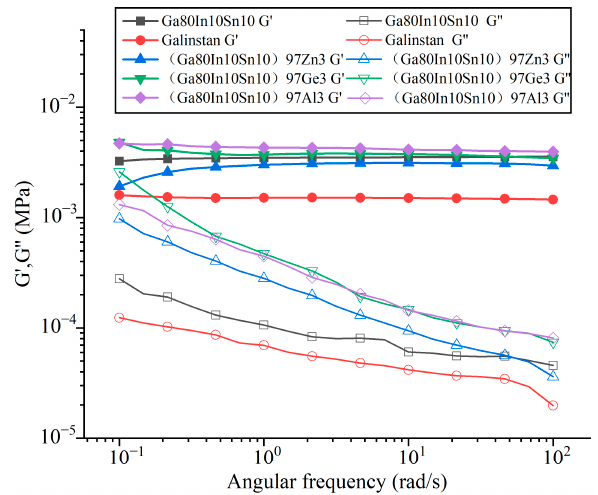
Figure 10. Storage modulus (G’) and loss modulus (G”) are plotted as a function of the angular frequency for gallium-based alloys.